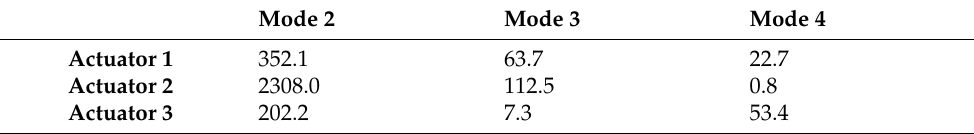
Table 6. Weighted gains g i , j evaluated for the i -th vibration mode and the j -th actuator.